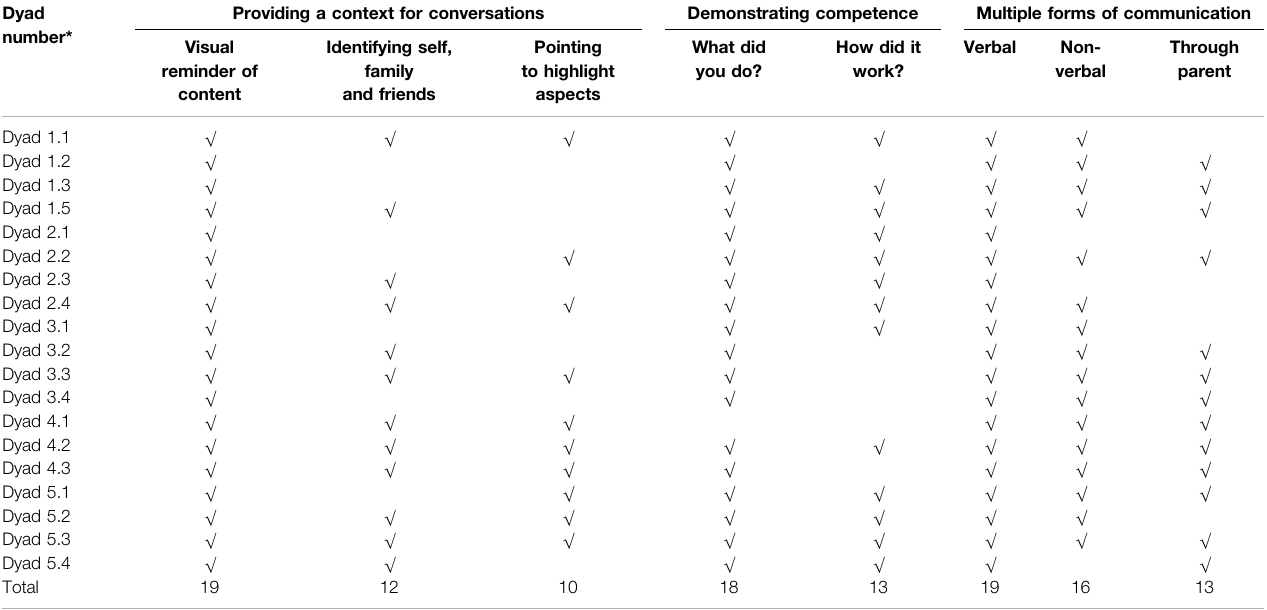
TABLE 3 | Occurrence of common themes across dyads in relation to how the photobooks assisted the children in demonstrating their understanding of how the science exhibits